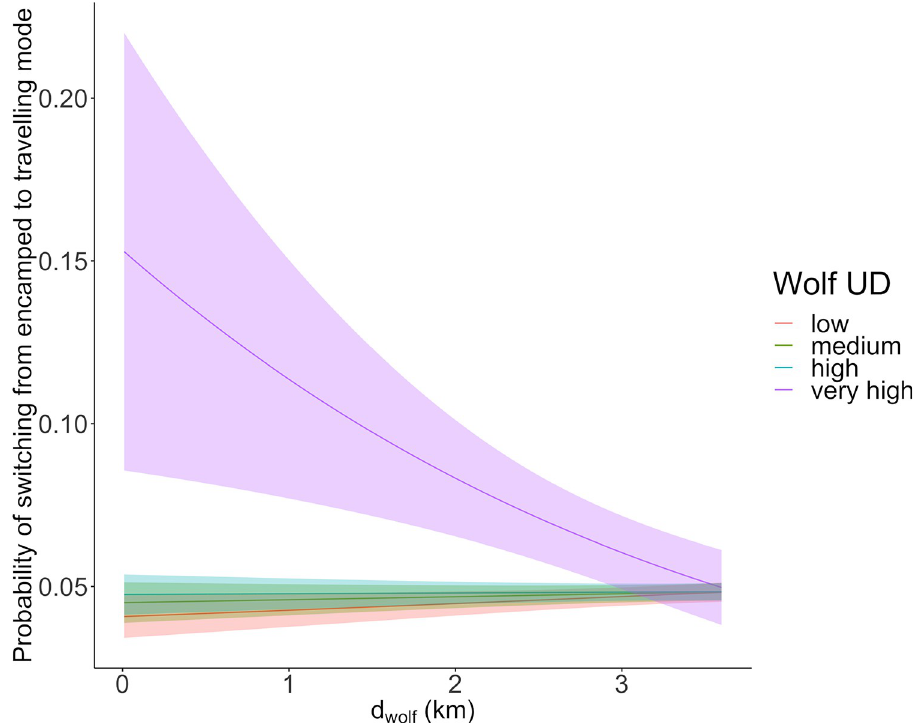
Fig 5. Estimated probability of switching from encamped to travelling mode of movement and 95% confidence interval, in plains bison during summer, according to wolf distance and local intensity of wolf utilization distribution (wolf UD). Coefficient estimates and standard errors were obtained from the fit of a mixed-effects generalized linear model with binomial distribution on 27,101 geolocations from 32 plains bison followed between 2007 and 2016 in Prince Albert National Park (SK, Canada). Probabilities were calculated here, by setting period of day and meadow variables to day and 1, respectively (see Table 3).